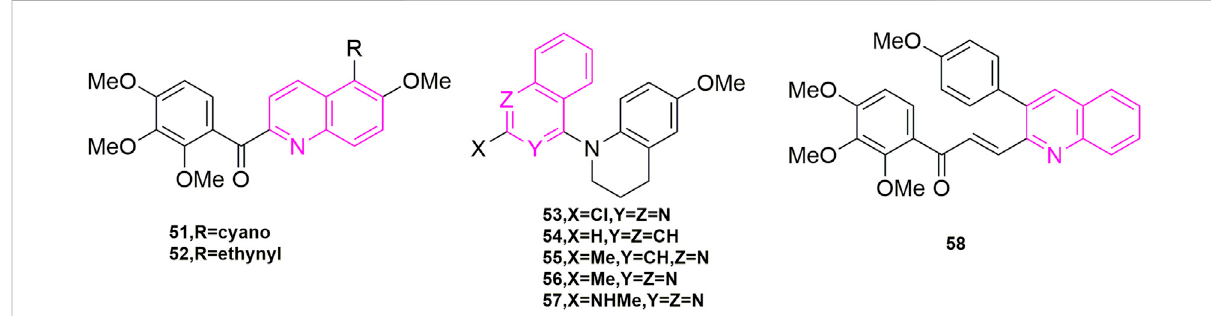
The structures of the compounds designed by Lee et al. (2012), Wang et al. (2013b), and Tseng et al.